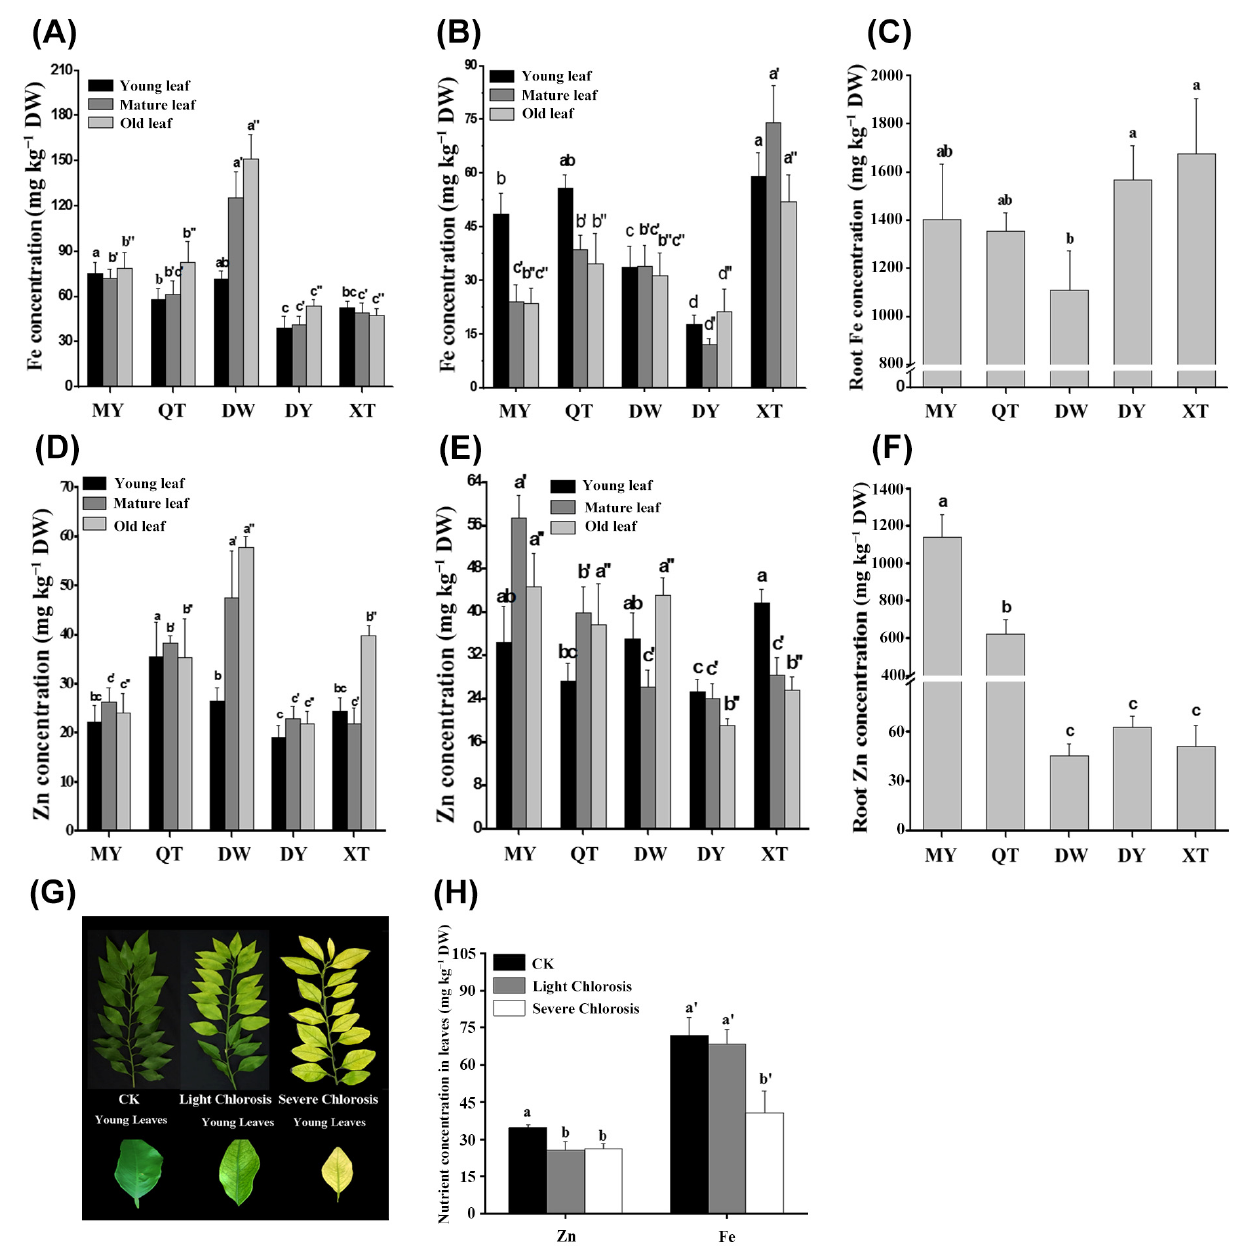
Figure 2. Fe concentration in citrus leaves ( A ), stems ( B ), and roots ( C ) in different orchards. Zn concentration in citrus leaves ( D ), stems ( E ), and roots ( F ) in different orchards. Different letters above the bars indicate significant difference among different orchards ( p < 0.05), and a, a’, a” was for young leaf, mature leaf and old leaf, respectively. ( G ) The diverse severity of chlorosis symptoms on citrus leaf. ( H ) Zn and Fe concentration in healthy and chlorotic citrus leaves. a, a’ was used for the significant difference of Zn or Fe concentration, respectively. Table 3. Fruit quality and mineral nutrient concentration of the citrus hybrid cv. Beni-Madonna, the significant difference of different citrus orchards at p < 0.05 was indicated by small letters.